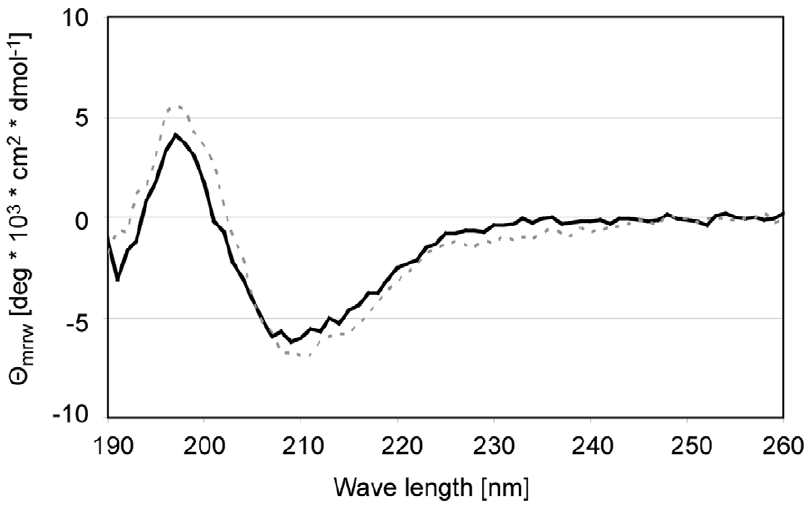
Figure 5. CD spectra of natural Bla g 2 (black line) and rBla g 2-N93Q (gray dashed).